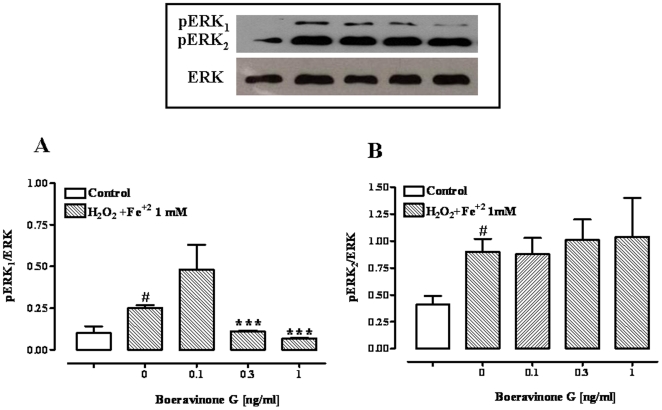
Effect of boeravinone G (0.1–1 ng/ml) on pERK1 (A) and pERK2 (B) expression.Quantitative analysis and representative western blot analysis of pERK1 and pERK2 in Caco-2 cells exposed to Fenton's reagent (H2O2/Fe2+ 1 mM) without or with boeravinone G (0.1–1 ng/ml). The results were normalized with anti-ERK2 (pERK1/2/ERK2). #p<0.01 vs control (vehicle); ***p<0.001 vs H2O2/Fe2+ alone.